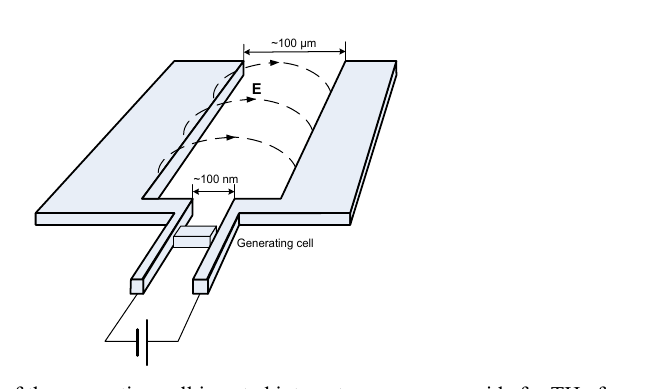
Fig. 1. Schematic view of the generating cell inserted into antenna or waveguide for THz frequencies of